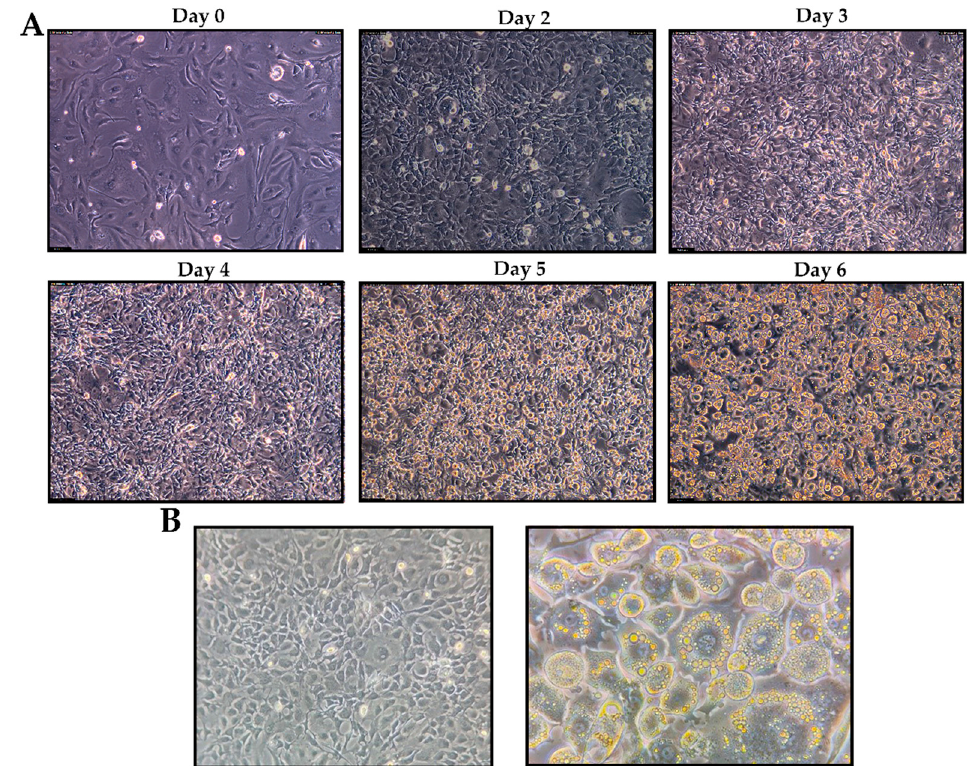
Figure 9 . Differentiation and identification of 3T3-L1 adipocytes. ( A ) Differentiation process of 3T3-L1 preadipocytes in the inverted microscope (100×). ( B ) Differentiation process of 3T3-L1 preadipocytes in the inverted microscope (400×).